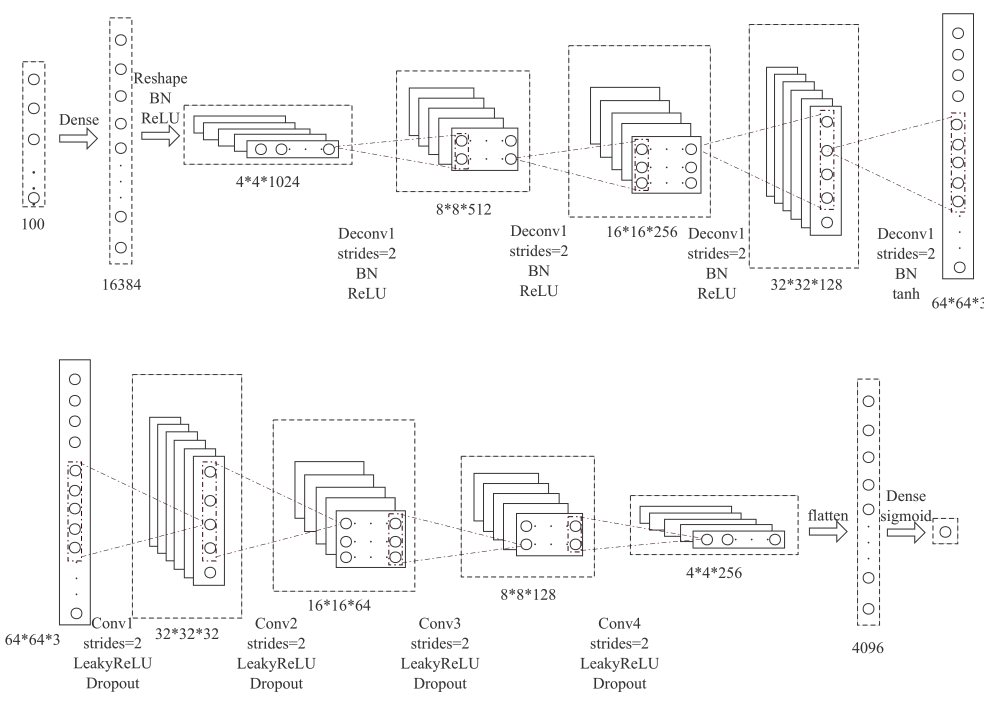
Figure 5. A 100 dimensional uniform distribution z is projected and